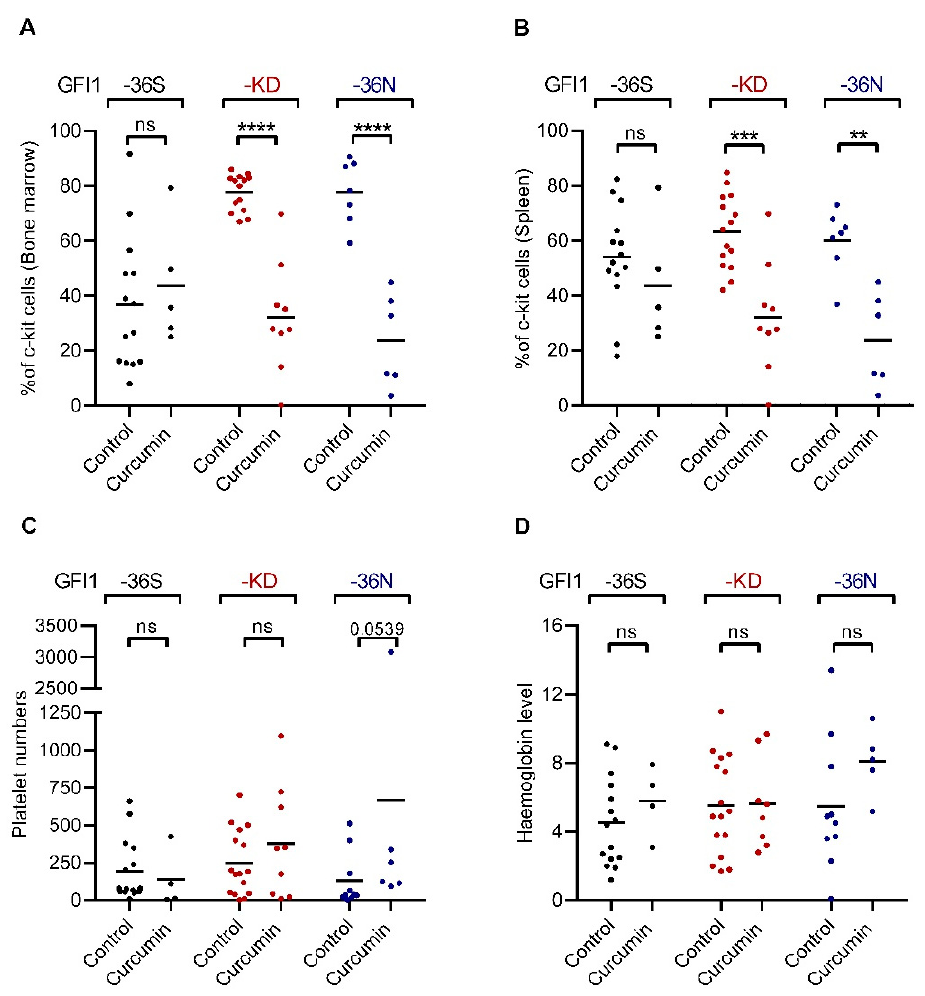
Figure 2. Curcumin treatment affected parameters contributing to AML development. ( A , B ). Percentage of c-kit positive (c-kit+) cells in the bone marrow (BM) and spleen in the vehicle and curcumin-treated GFI1-36S/ -36N and -KD, NUP98/HOXD13-tg mice. ( C , D ). Quantification of platelets and haemoglobin in curcumin and vehicle-treated GFI1-36S/ -36N and -KD, NUP98/HOXD13-tg mice. **** p < 0.001, *** p < 0.005, ** p < 0.01. ns: not significant